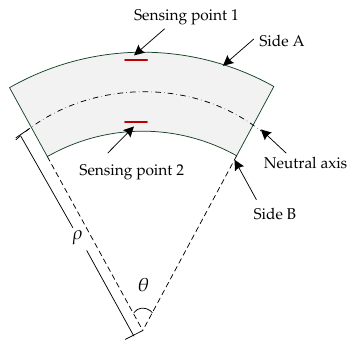
Figure 3. Measurement mechanism of each of the detecting unit.